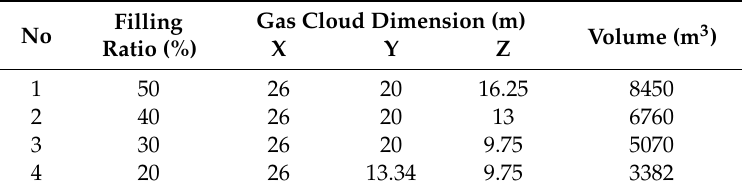
Table 2. Gas filling ratio and gas volume above the drill floor.